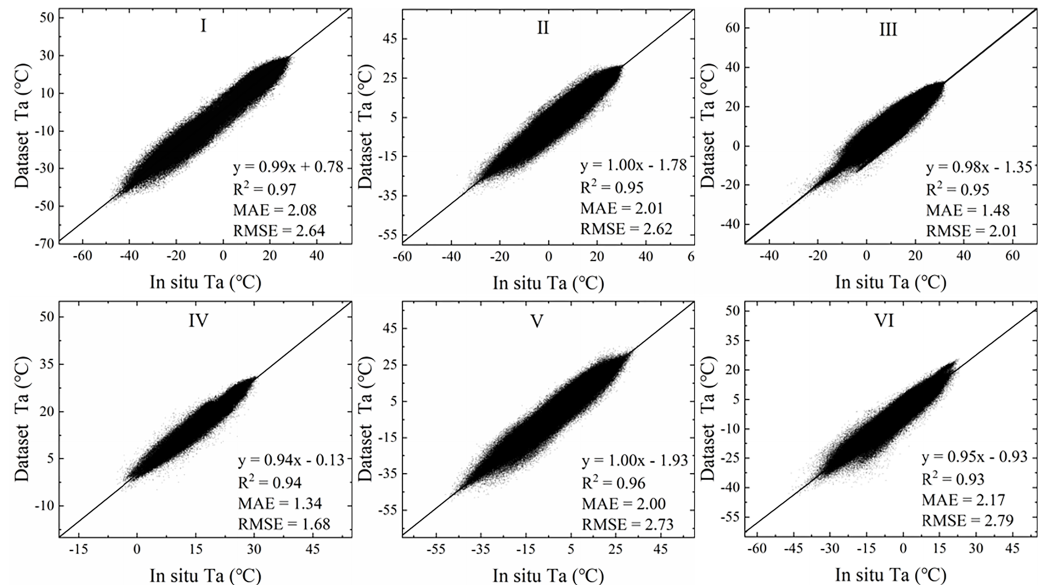
Figure 7. Scatter diagrams of the T min output from the T a model against ground station data; statistical accuracy measures ( R 2 , MAE, and RMSE) are also